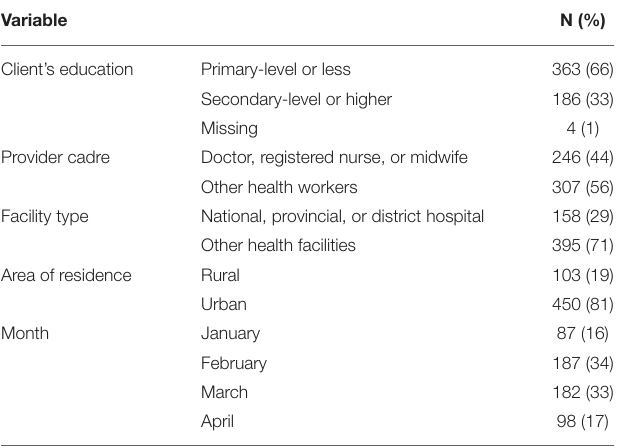
TABLE 6 | Distribution of first ANC visits by month, client, provider, and facility characteristics.